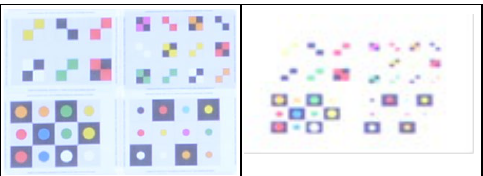
Figure 1. Ground control network of Kortowo test field visualized in Google Earth Pro window